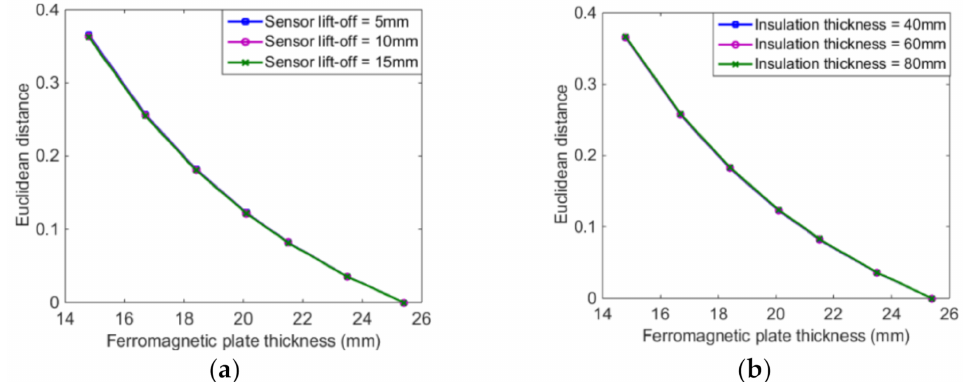
Figure 9. Euclidean distances. ( a ) under different sensor lift-offs. ( b ) under different insulation